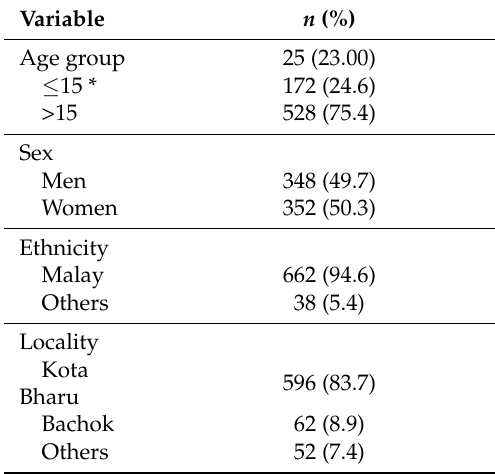
Table 2. Socio-demographic characteristics of the respondents ( n = 700).